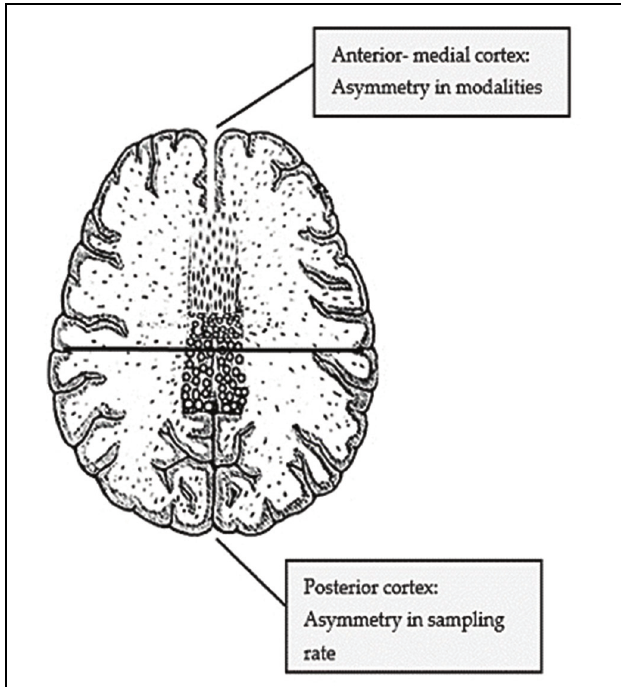
FIGURE 4 | Illustration of the AST hypothesis (Theofanopoulou Mikaella; Rights